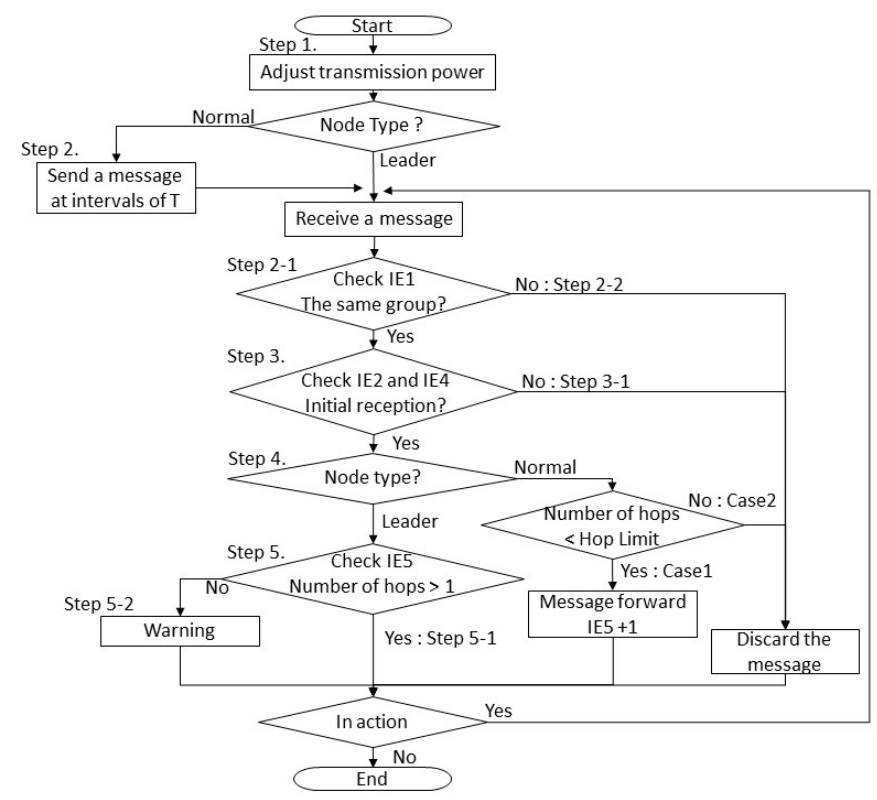
Figure 5. Flowchart for the autonomous response-type stray node detection protocol.